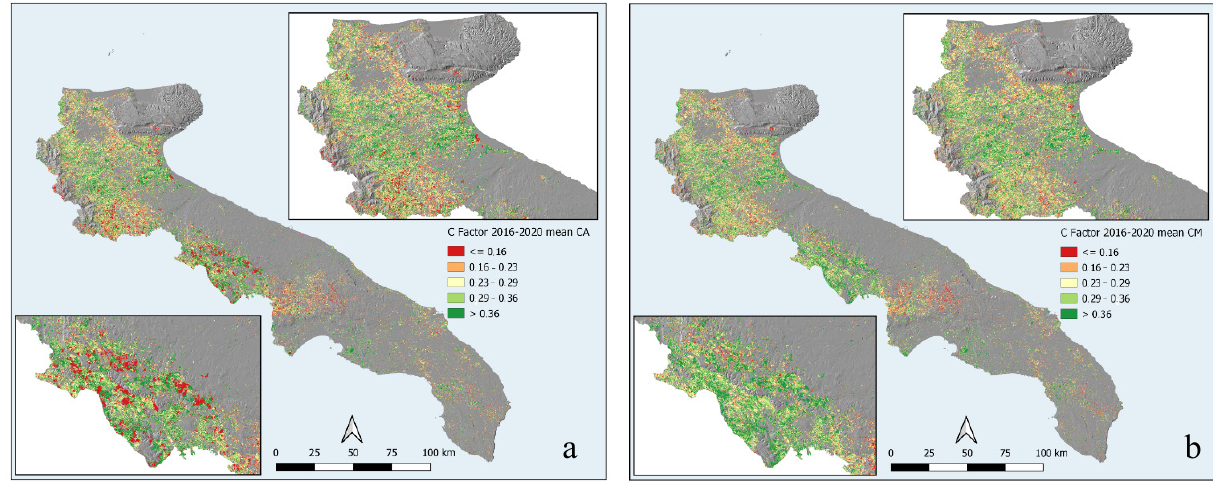
Figure 9. Cover and management ( C ) factor average maps (2016–2020) of the Apulia region under ( a ) conventional management and ( b ) conservation agriculture for annual cropland.